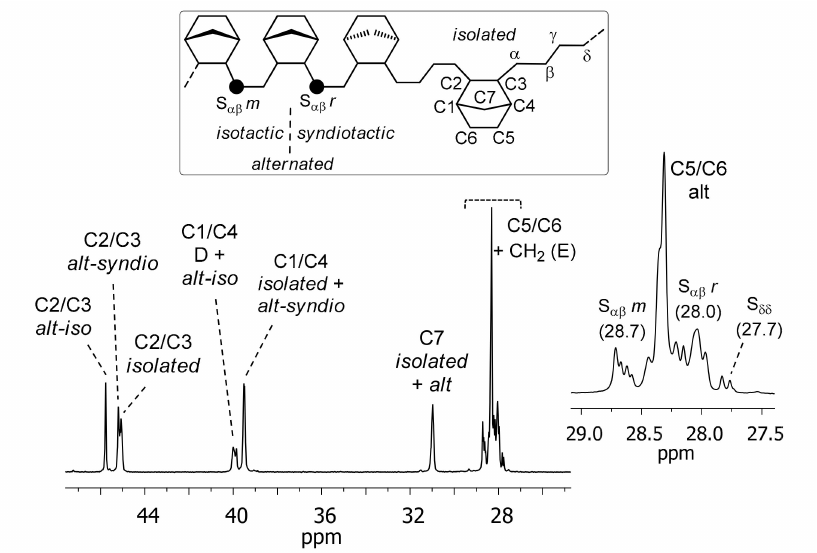
Figure 2. 13 C-NMR spectrum of entry 8 (Table 2, NB = 37.8